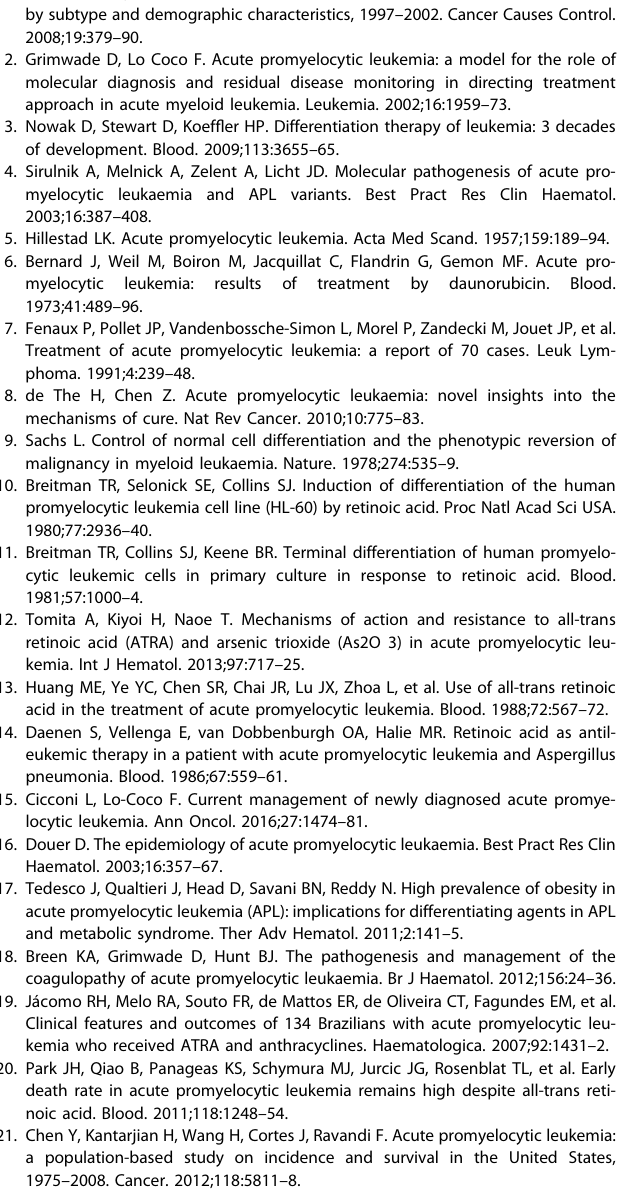
treatment landscape and allowed the development of a chemotherapy-free regimen with high success rates. GO, or IDA, should be added early during induction therapy in patients with high-risk disease. In the absence or unavailability of ATO, ATRA plus chemotherapy combinations represent a reasonable alter- native. Despite this progress, induction mortality remains one of the main obstacles in APL therapy. Clinicians must initiate ATRA treatment (on the earliest suspicion), diagnose promptly, and monitor vigorously during therapy to minimize expected compli- cations of APL. Several oral arsenic formulations are highly bioavailable and effective in patients with APL. Already approved in China, oral arsenic therapy needs to be further explored in the United States and